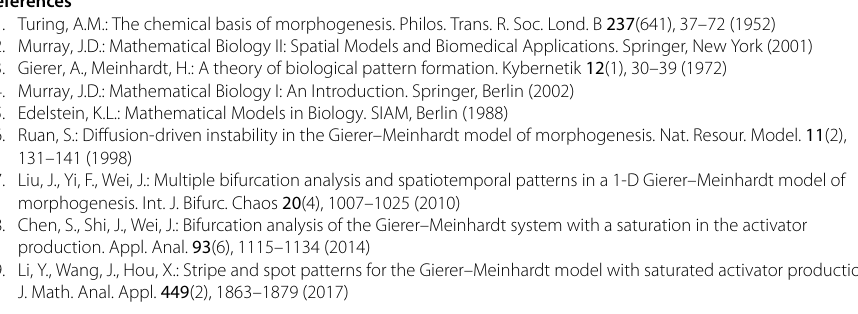
odic solution through Hopf bifurcation. In the green one, the equilibrium is also unstable, whereas the limit cycle experiences a Turing bifurcation and becomes unstable. Turing patterns for the limit cycle may occur in this